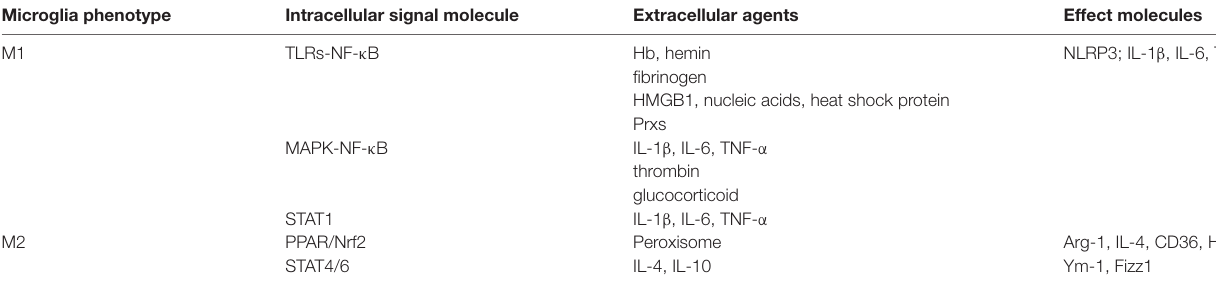
TABLE 2 | Signaling pathways of microglia polarization.